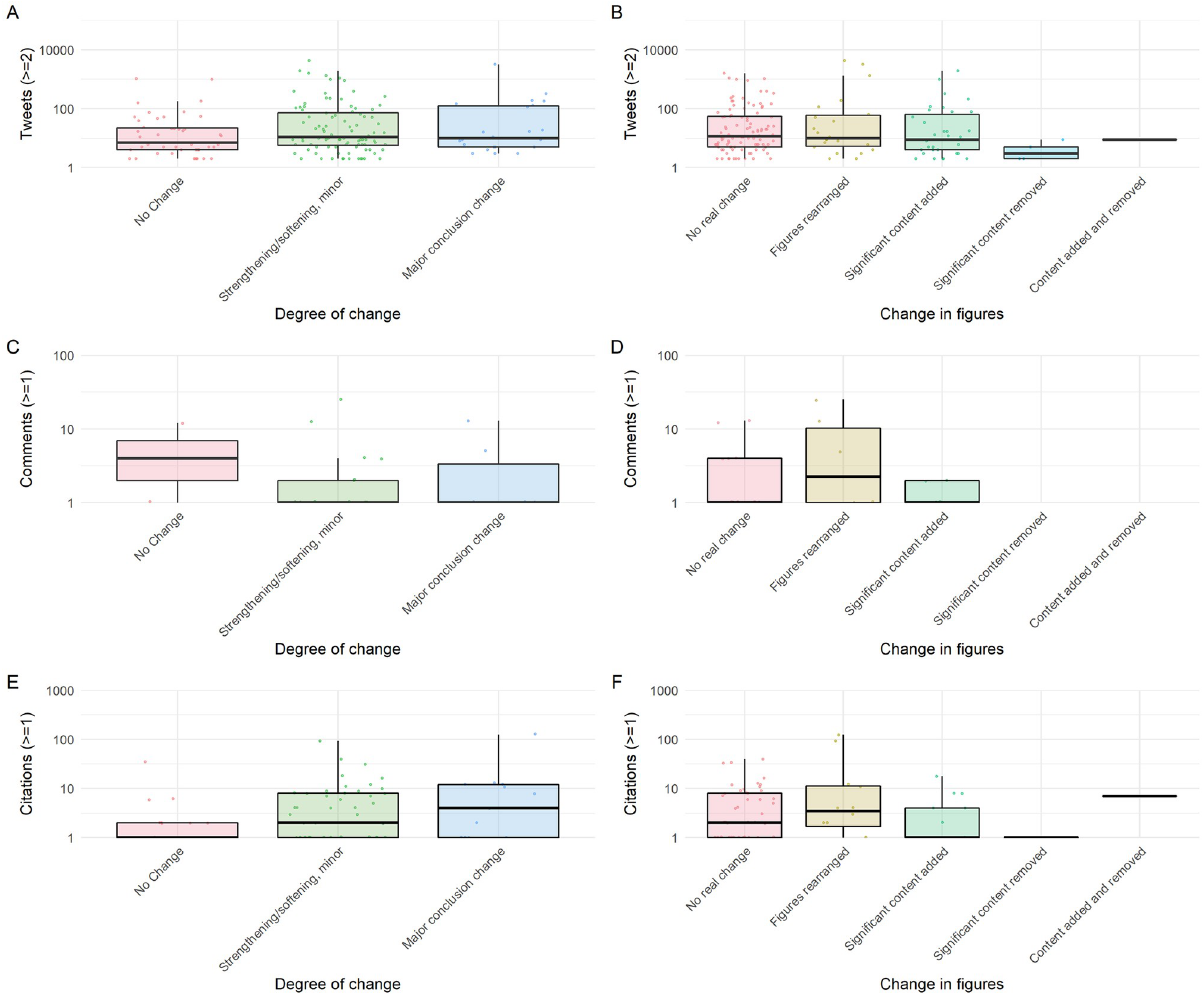
Fig 4. Altmetric data for overall degree of change in abstracts and figures. (A) Number of tweets (at least 2) and overall abstract change. (B) Number of tweets (at least 2) and overall change in figures. (C) Number of comments (at least 1) and overall abstract change. (D) Number of comments (at least 1) and overall change in figures. (E) Number of preprint citations (at least 1) based on overall abstract change. (F) Number of preprint citations (at least 1) based on overall change in figures. The data underlying this figure may be found at